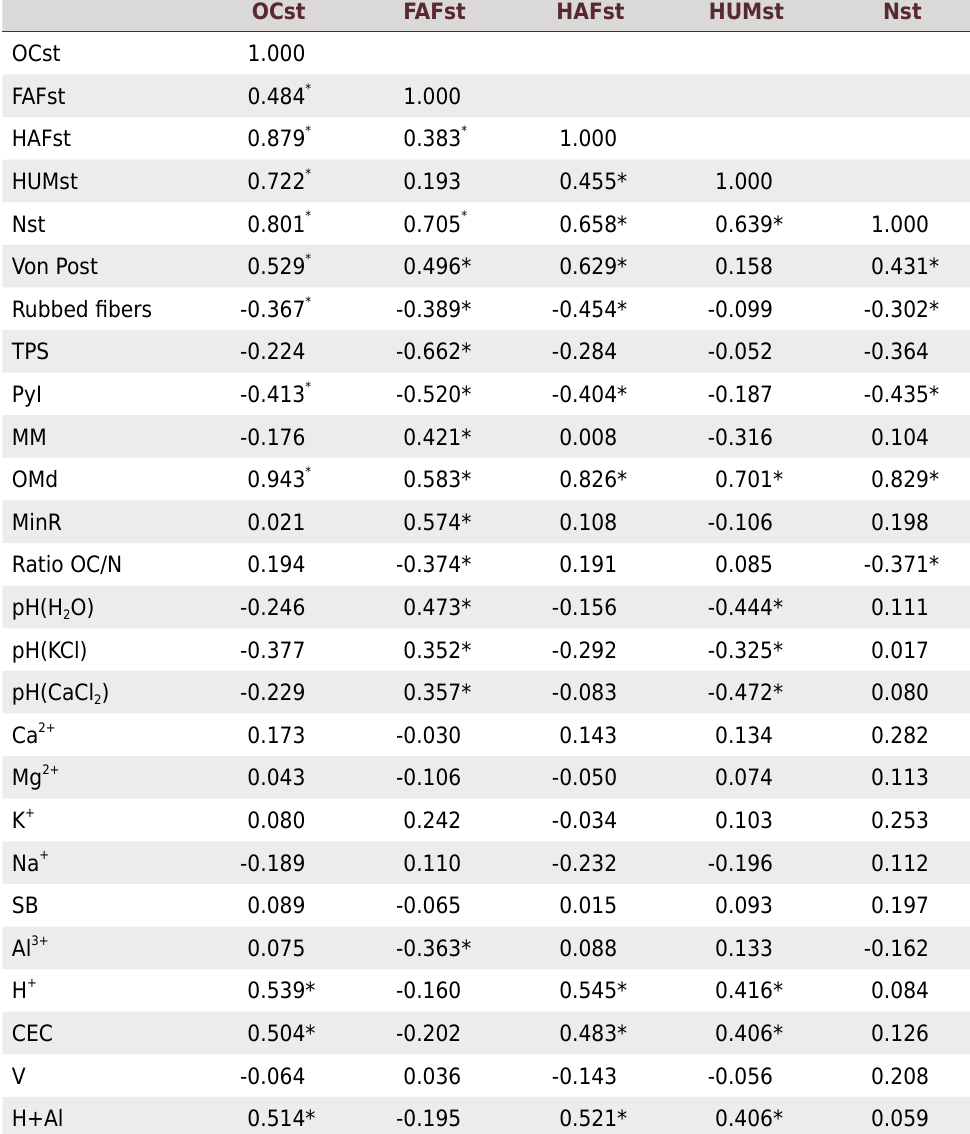
Table 7. Pearson’s correlation coefficient for organic carbon (OCst) and nitrogen (Nst) stocks, fulvic acid fraction (FAFst), humic acid fraction (HAFst), and humin (HUMst), and other chemical and physical properties of the Organosols